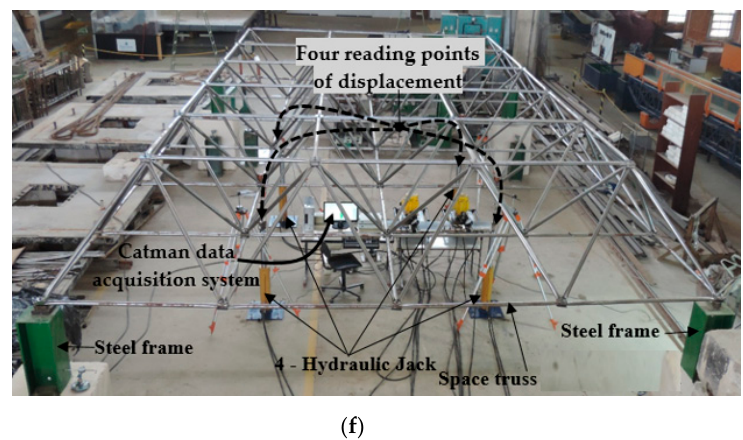
Figure 17. Detail of prototypes: ( a ) Space truss with typical connection without spacer, ( b ) space truss with spacers made of encapsulated concrete with steel fiber, ( c ) space truss with spacers made of concrete with steel fiber, but not encapsulated, ( d ) length of the steel bars of the space trusses, ( e , f ) details of the instrumentation used.